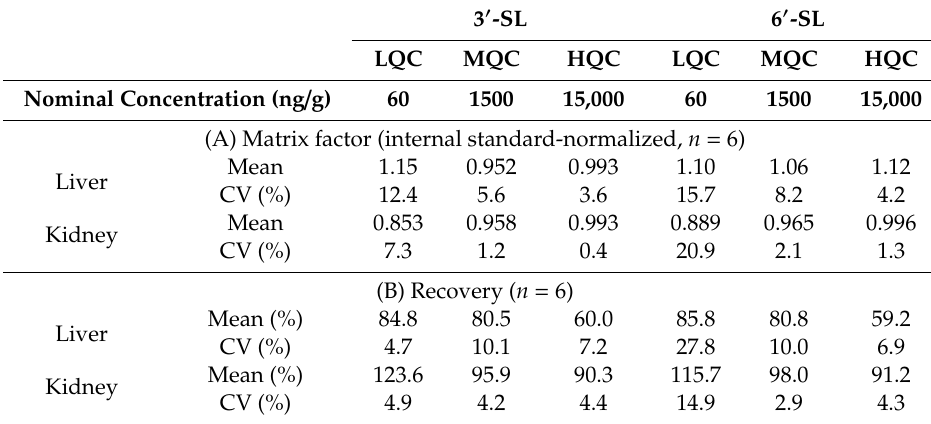
Table 3. Matrix e ff ect and recovery